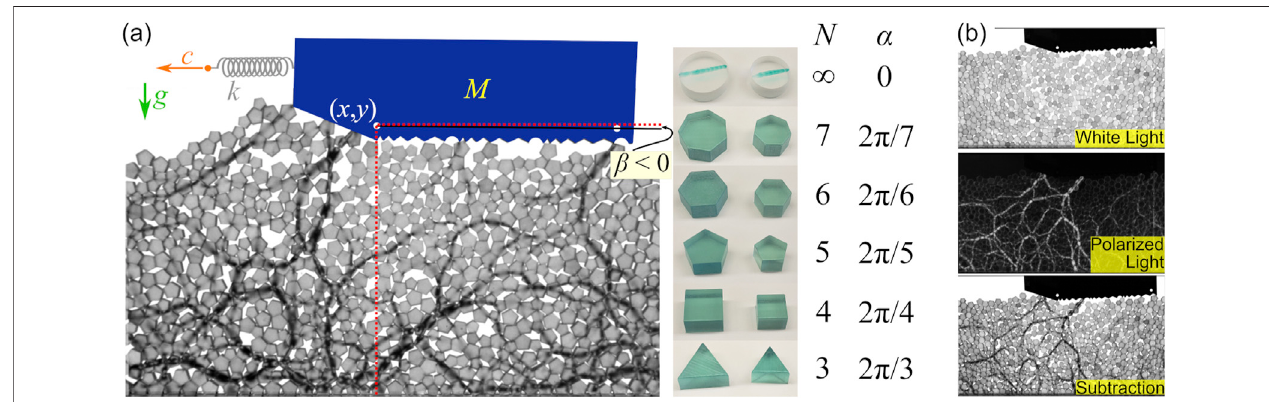
FIGURE1|(A) Schematicofsystemunderstudy.Thesliderofweight Mg restsontopofagravity-packedgranularmaterialandispulledbyaspringofstiffness k at speed c . The location ( x , y ) of the front hole is used to represent the position of the slider, and the angle β from the horizontal to the segment joining the two holes represents the orientation of the slider, with β > 0 corresponding to counterclockwise rotation. (B) Subtraction images (bottom) are obtained by subtracting white light images (top) and photoelastic images (middle).